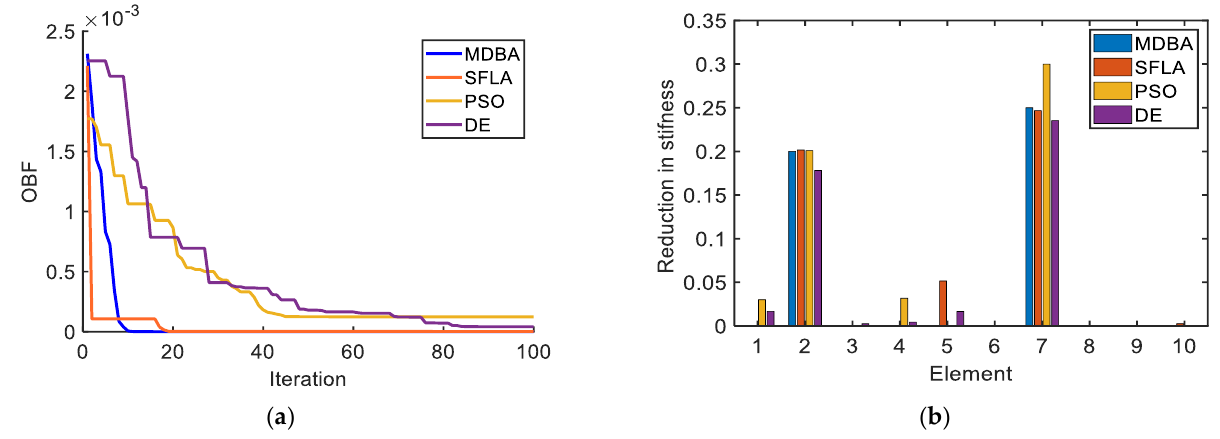
Figure 6. ( a ) The convergence curves achieved by four different algorithms for objection function. ( b ) The identification results of the damaged case by four different algorithms. Table 1. The identification results of the damaged case by four different algorithms.